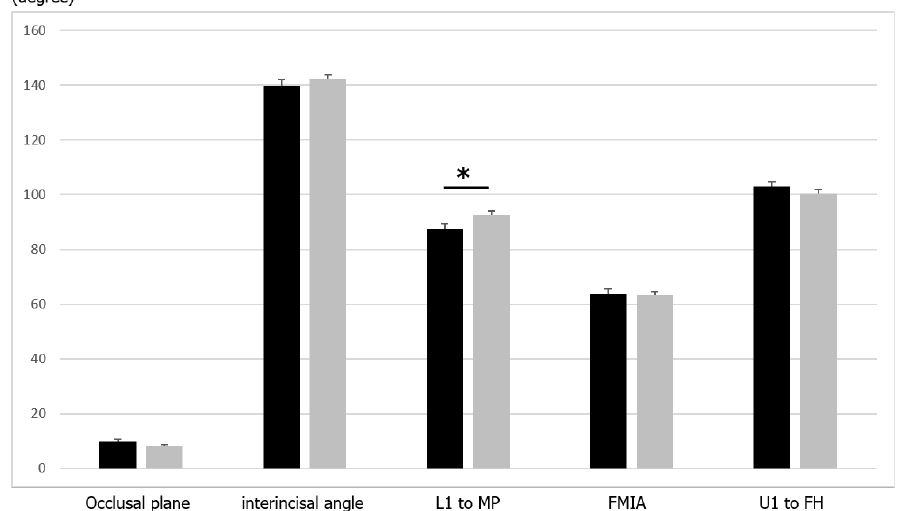
Figure 4. Comparison of dentoalveolar variables between samurai and commoners. Values are presented as means ± standard deviations. The asterisks represent significant differences between the groups. Black, samurai group; grey, commoners.